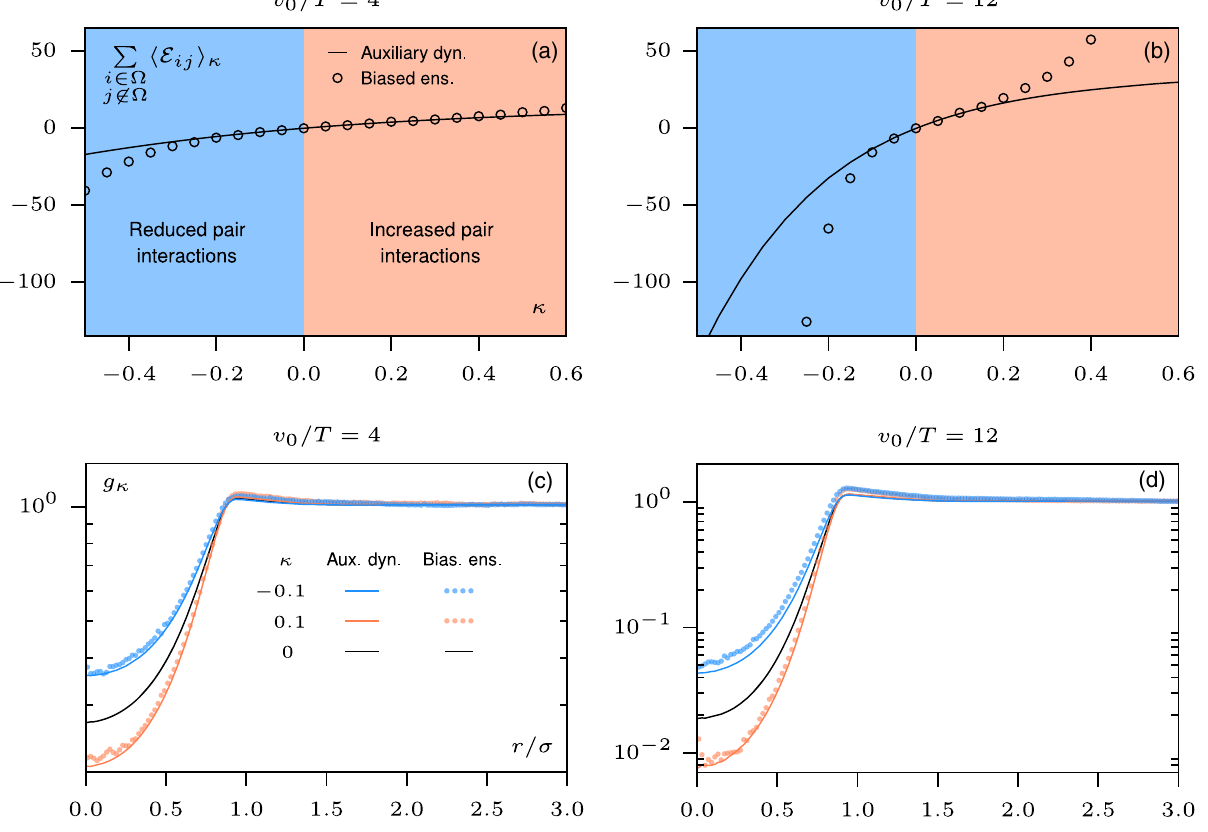
P P FIG. 5. (a),(b) Average biasing observable h E ij i κ ¼ h L v ð r i − r j Þi κ =T as a function of bias parameter κ , where L i ∈ Ω ;j ∉ Ω i ∈ Ω ;j ∉ Ω and v , respectively, denote the evolution operator and the pair potential of the equilibrium dynamics (28). Results from the first-order auxiliary dynamics (solid lines) and from a direct sampling of the biased ensemble (circles) coincide for a finite range of κ . (c),(d) Biased density correlation g κ as a function of interparticle distance r= σ obtained from auxiliary dynamics (solid lines) and direct sampling (dotted lines). At leading order, our dynamical bias effectively renormalizes the potential v by a factor κ for specific pairs of particles f i ∈ Ω ; j ∉ Ω g , in satisfying agreement with direct sampling. This renormalization illustrates the control of liquid structure at small κ and weak interactions. Simulation details are in Appendix